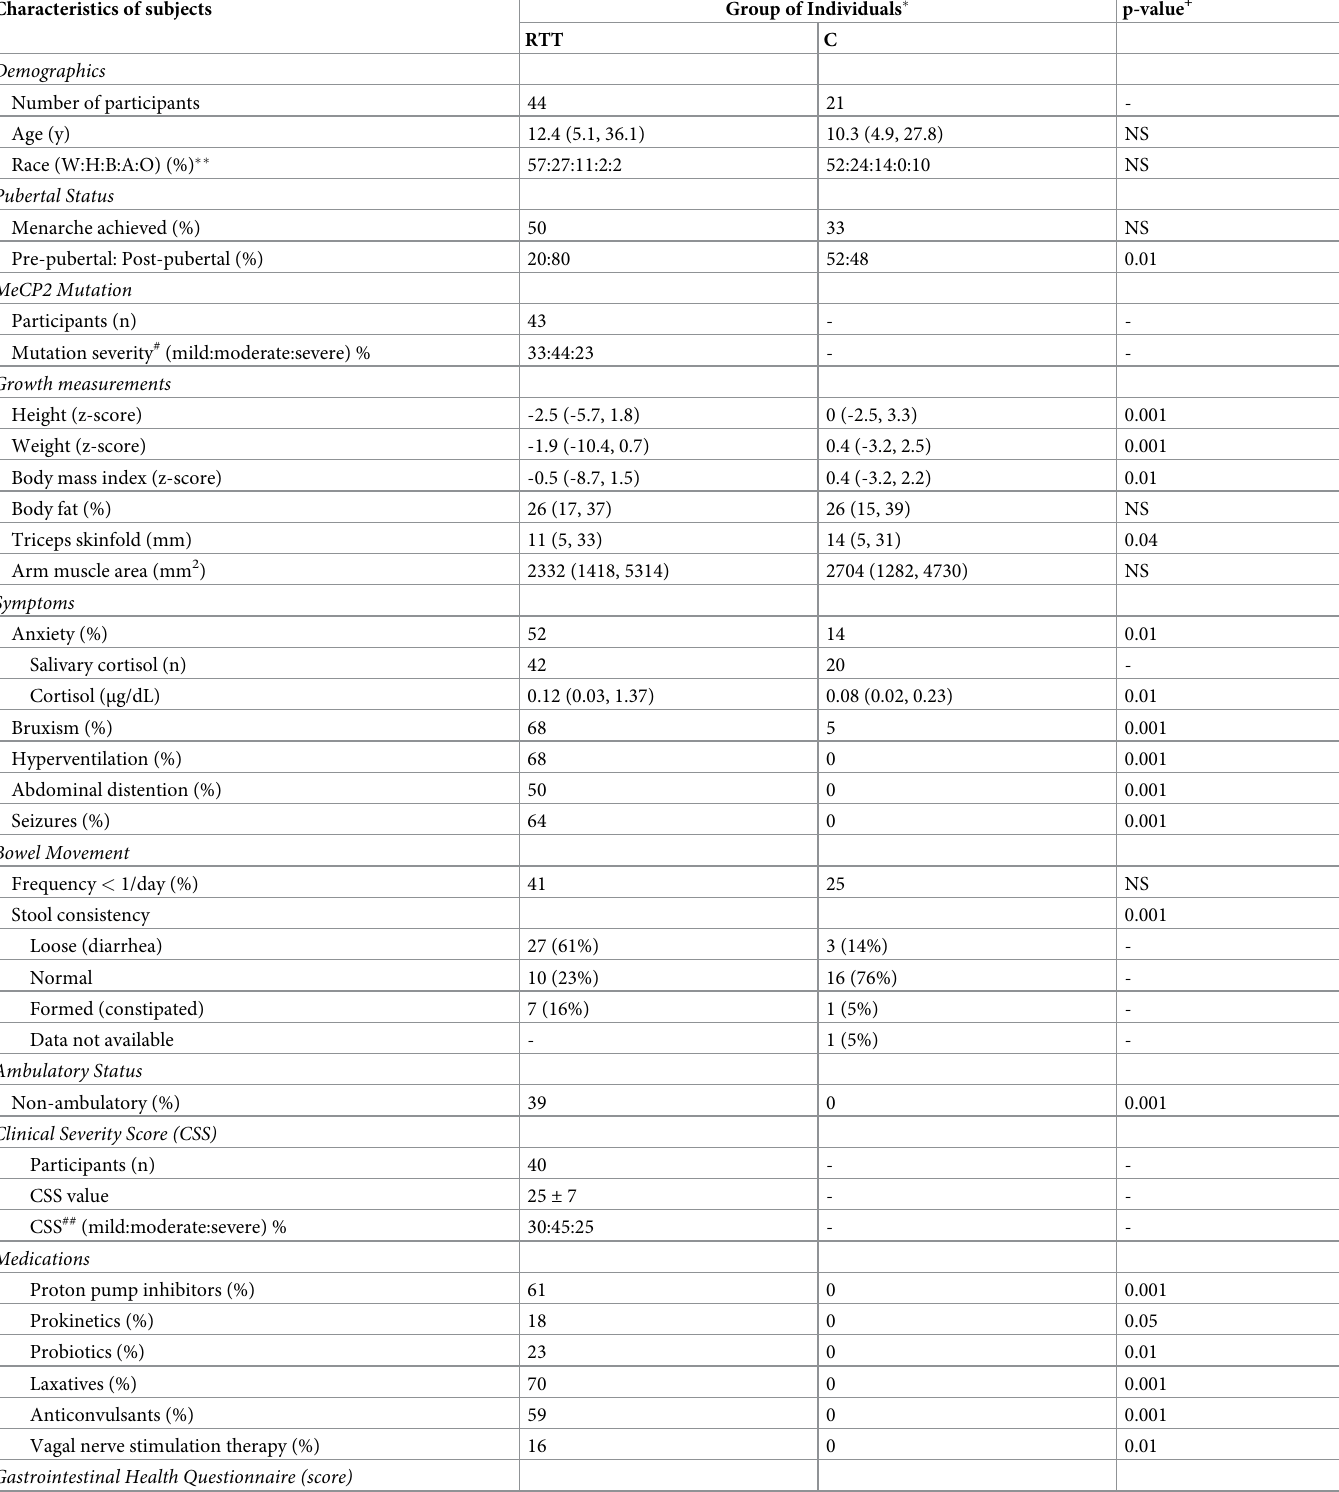
Table 1. Demographic and clinical characteristics of individuals with Rett syndrome (RTT) and unaffected Controls (C). Characteristics of